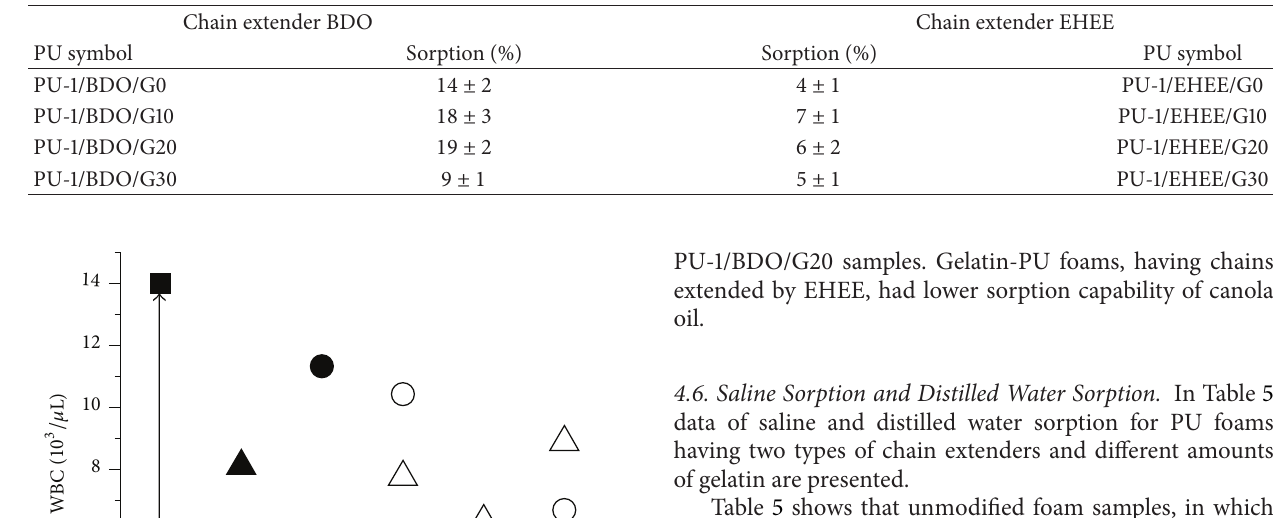
Table 4: Canola oil sorption of PU foams prepared from different chain extenders and various amounts of gelatin.